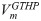
Parameter variation plot for (A-C) Vmax of GTHP (VmGTHP) and (D-F) Vmax of NOX (VmNOX) under the normal condition at different time points.